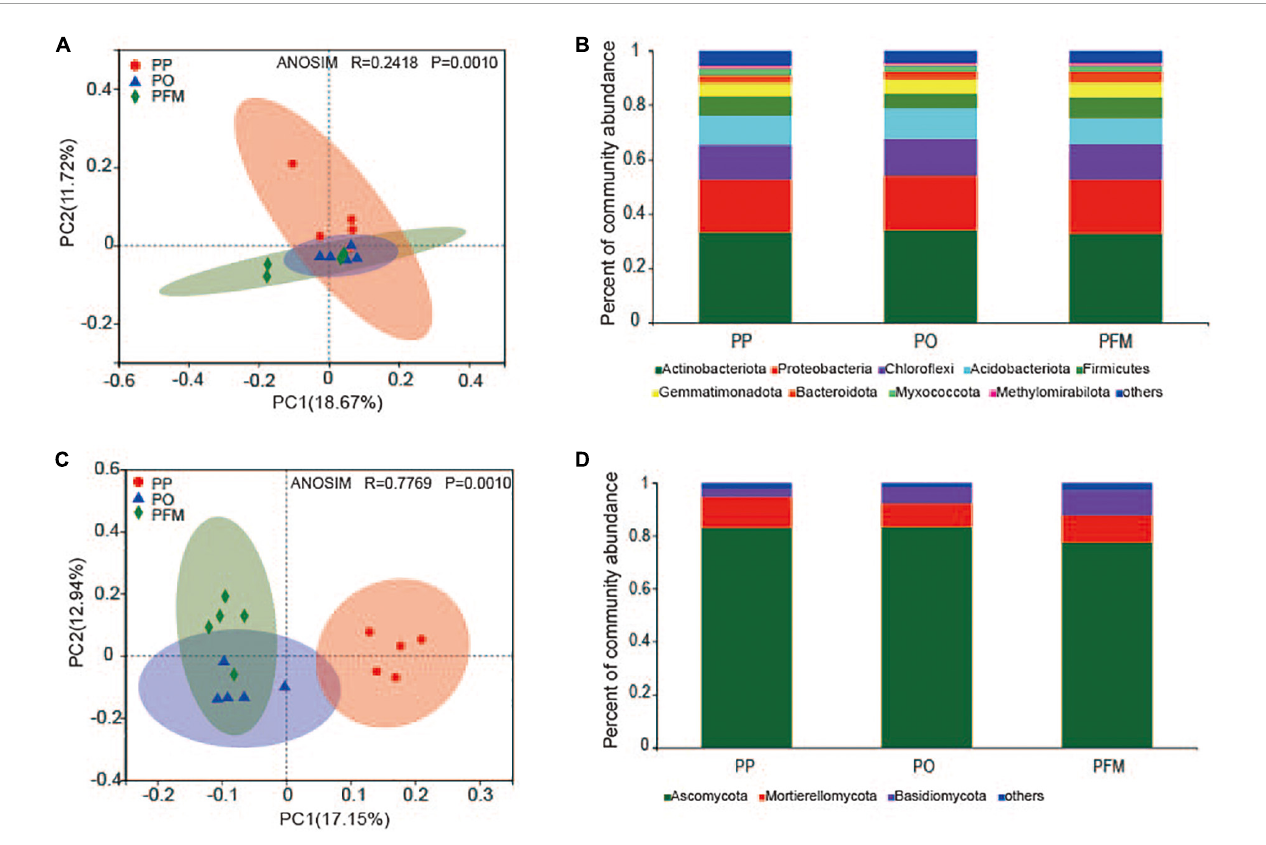
FIGURE2 Principal coordinate analysis (PCoA) showing the changes in bacterial (A) and fungal (C) community composition. The abundances of total bacterial (B) and fungal (D) communities are based on the proportional frequencies of 16S rRNA and ITS sequences. PP, potato continuous cropping; PO, potato–oat rotation; PFM, potato–forage maize